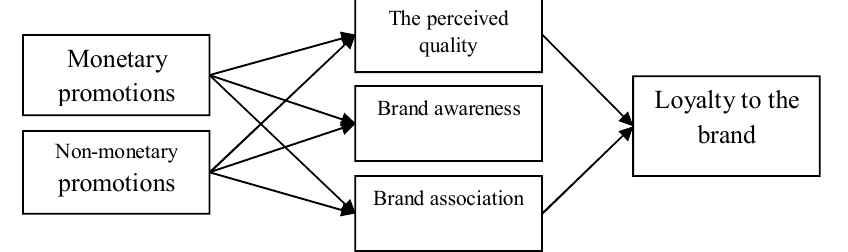
Fig. 1. Research Conceptual